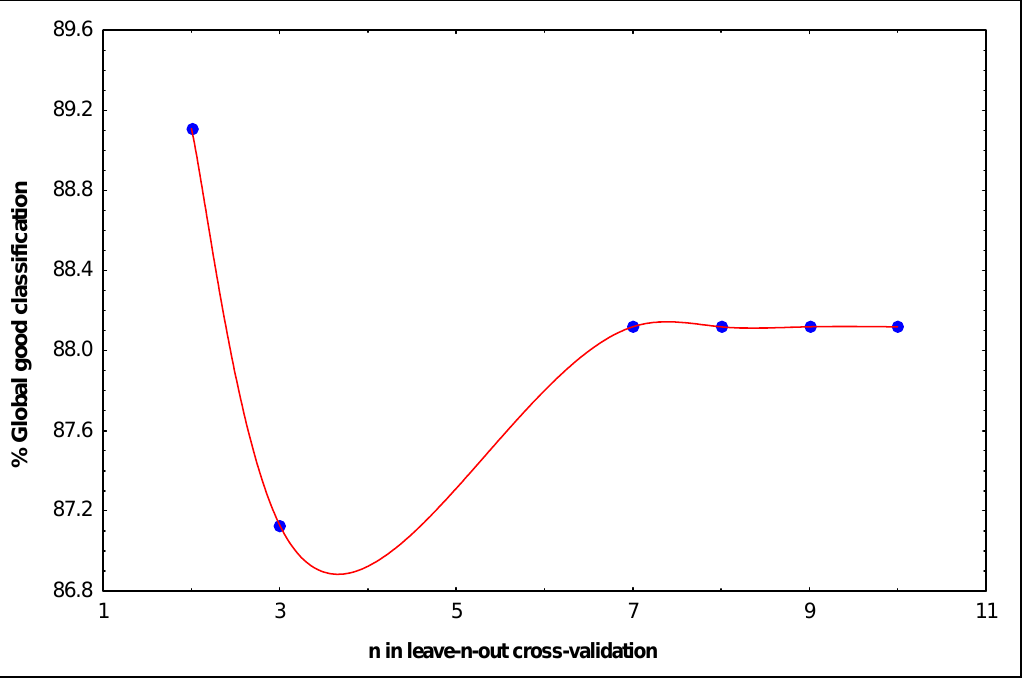
Figure 2. Behavior of the global or total percentage of good classification in different n - fold cross-validation analysis.